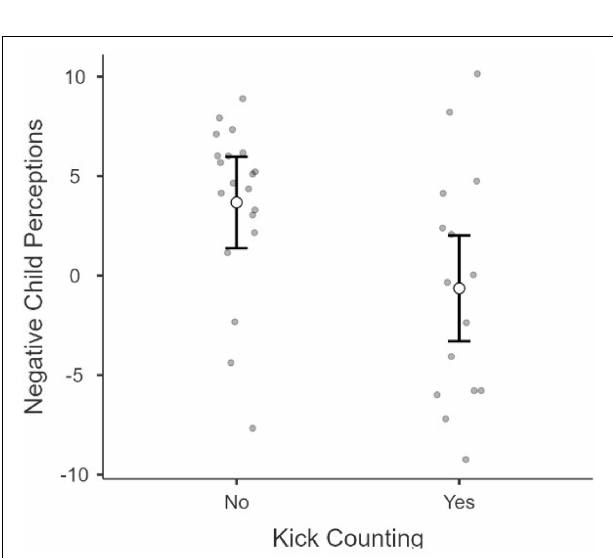
( p s > 0.195). This suggests that mothers engaging in FCK endorse overall fewer negative perceptions about their